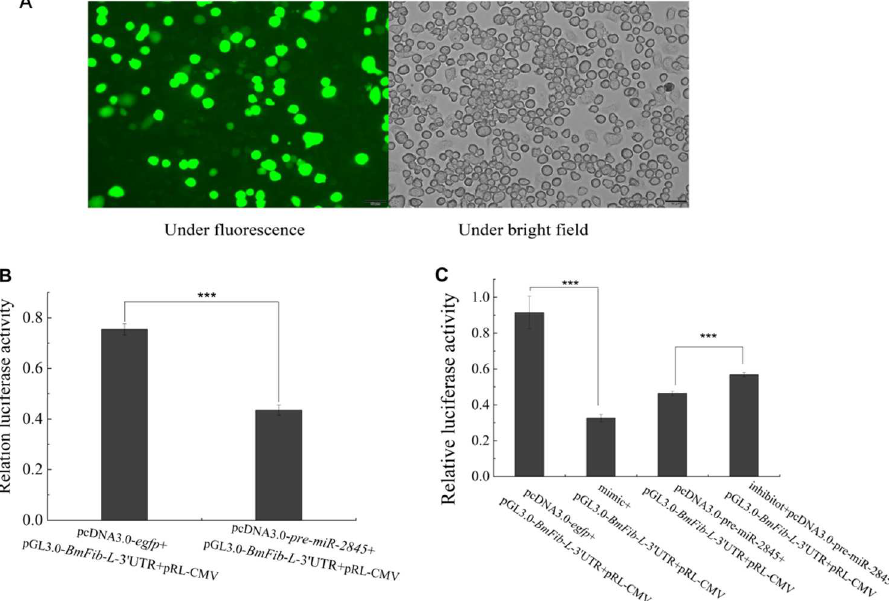
Fig 4. Regulatory function of bmo-miR-2845 on expression levels of BmFib-L in BmN cells. A. Green fluorescence in BmN cells (observed at 48 h post-transfection with recombinant plasmids). B. Comparison of luciferase activity in BmN cells of treatment group, the pcDNA3.0-pre-miR-2845 + pGL3.0- BmFib-L- 3’UTR + pRL-CMV group; the control group, and the pcDNA3.0- egfp + pGL3.0 - BmFib-L- 3’UTR + pRL-CMV group. C. Comparison of luciferase activity in BmN cells of different groups, including the mimic + pGL3.0- BmFib-L- 3’UTR + pRL-CMV group; the inhibitor + pcDNA3.0-pre-miR-2845 + pGL3.0- BmFib-L- 3’UTR + pRL-CMV group; the pcDNA3.0- egfp + pGL3.0- BmFib-L -3’UTR + pRL-CMV group; and the pcDNA3.0-pre-miR-2845 + pGL3.0- BmFib-L -3’UTR + pRL-CMV.